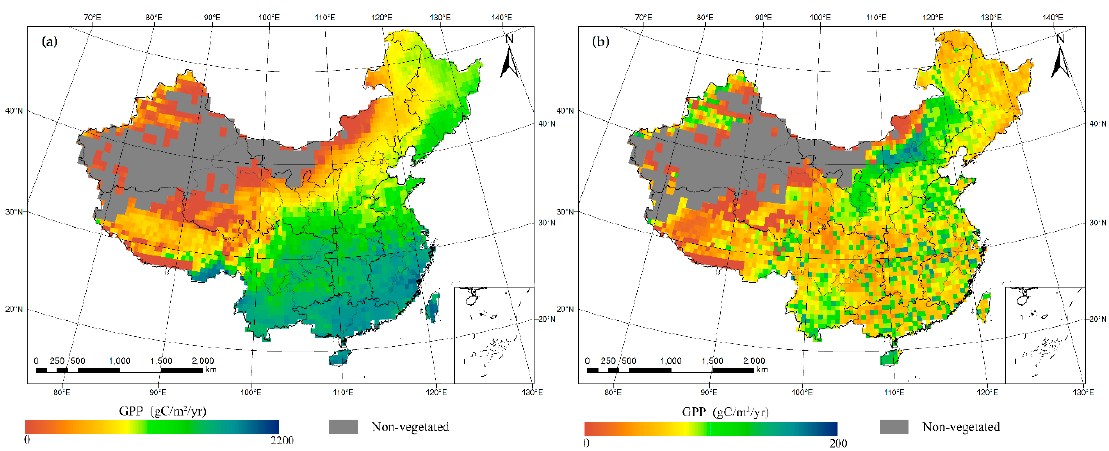
Figure 7. Spatial distributions of ( a ) annual averaged gross primary productivity (GPP); and ( b ) standard deviation ( SD ) of GPP during 2003–2012 in China.